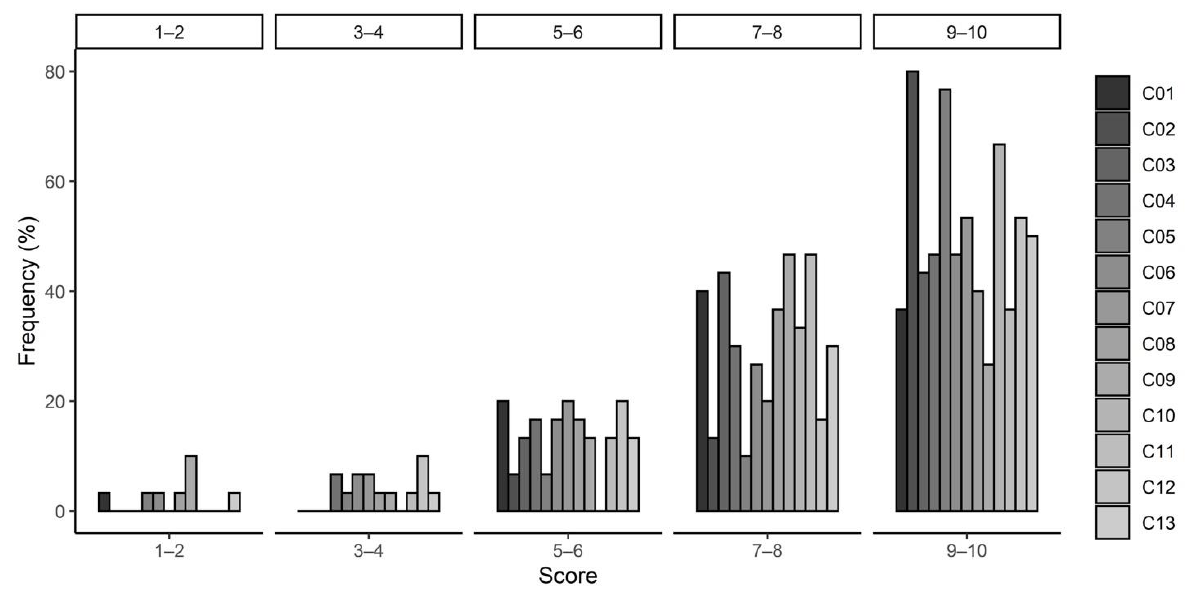
Figure 3. Frequency analysis of the criteria developed in this study.